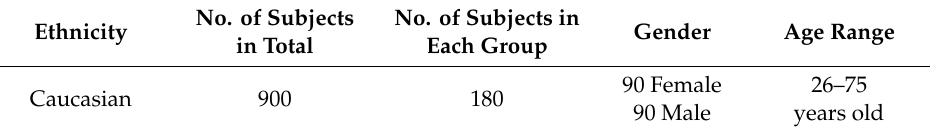
Table 2. The demography of the presented face